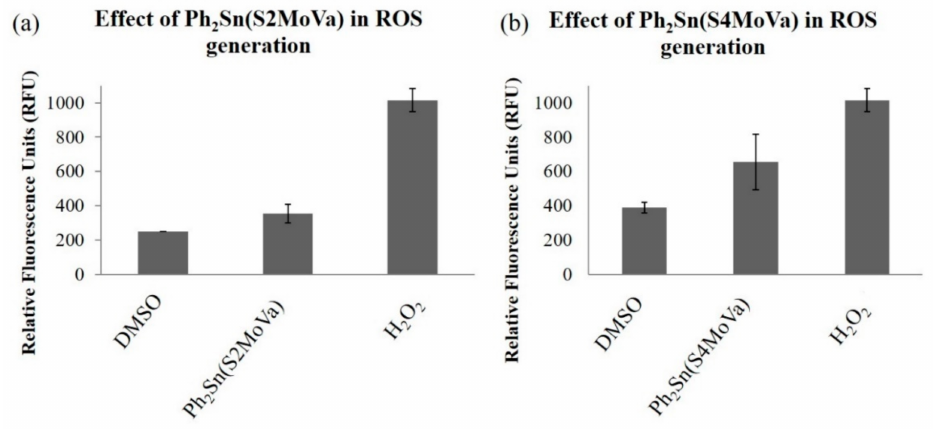
Figure 7. Percent reactive oxygen species (ROS) production in RT-112 cells treated with ( a ) Ph 2 Sn(S2MoVa) (0.31 µ M) ( b ) Ph 2 Sn(S4MoVa) (1.66 µ M) for 24 h and stained with 1 mM DCFH-DA for 60 minutes at 37 ◦ C. DMSO and H 2 O 2 acted as negative and positive controls, respectively.